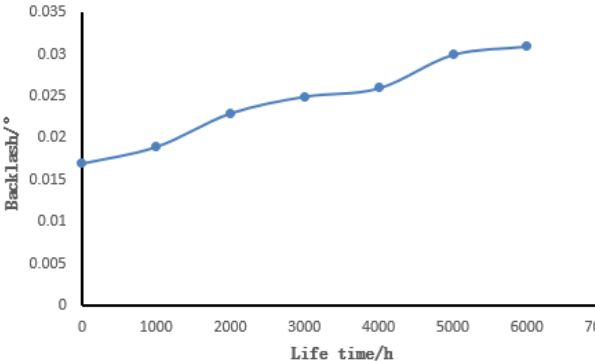
Figure 9. Backlash curve at torque 5 N.m.